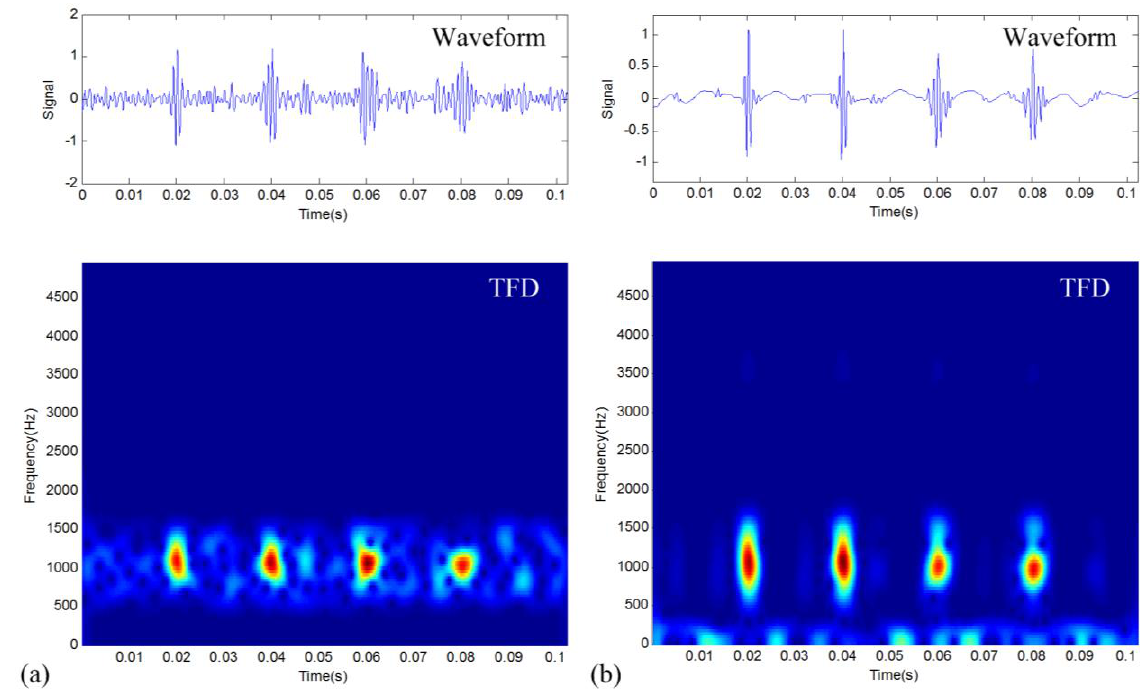
Figure 3. Denoising results of two traditional methods: ( a ) band-pass filtering and ( b ) DWT-based